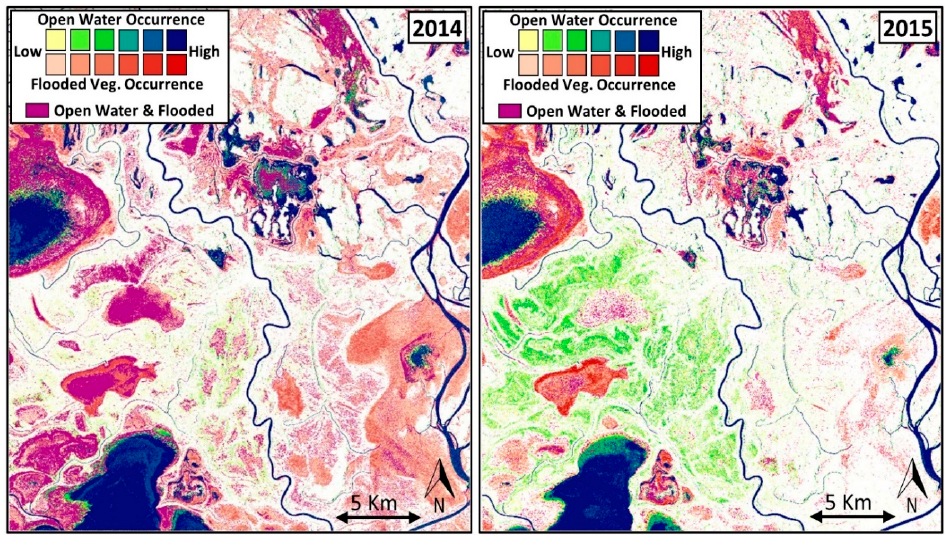
Figure 9. Flooded vegetation and hydroperiod of open water for 2014 and 2016 in the Peace-Athabasca Delta. Flooded vegetation is shown in red, whereas open surface water is shown in yellow to blue.